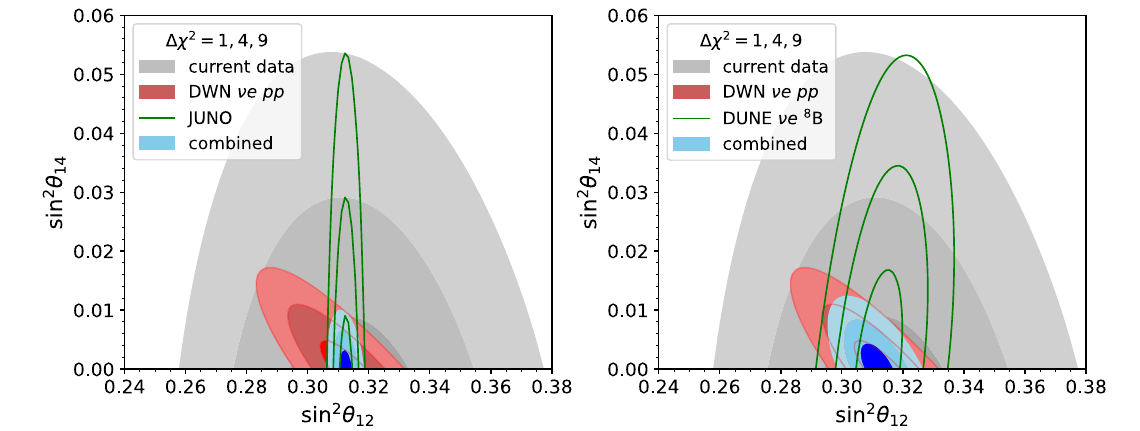
Fig. 12 Complementaritybetweendifferentprobesoflow-energyneu- trinos in exploring sterile neutrinos. Both panels show the sensitivity on the standard mixing angle θ 12 and the sterile mixing θ 14 . As we see,